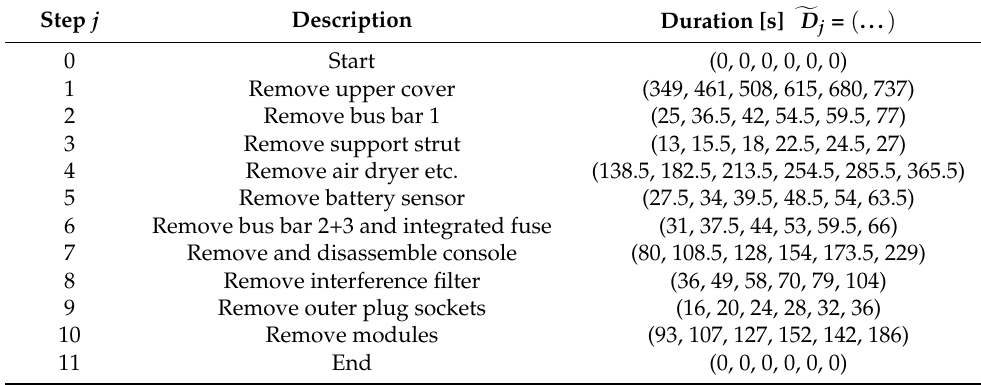
Table 5. Derived fuzzy durations for main disassembling steps in six-point